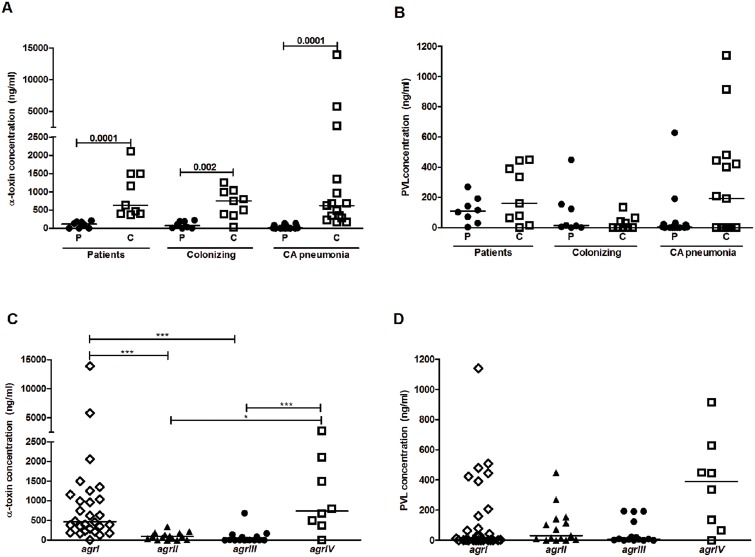
Levels of alpha-toxin expression correlate with cytotoxic profile and agr types.Amounts of alpha-toxin (α-toxin) (A) and Panton Valentine Leukocidin (PVL) (B) were determined by ELISA in the S. aureus bacterial supernatants (1∶50 dilutions) having either a cytotoxic (C; open symbols) or a proliferative (P; filled symbols) response profile. Supernatants prepared from isolates collected from colonized individuals (n = 17), patients (n = 17), or a confirmatory cohort of CA pneumonia (n = 31) are shown. Association between amount of α-toxin (C) and PVL (D) in the S. aureus bacterial supernatants (1∶50 dilutions; n = 65) with their respective agr types (agr I and IV, open symbol; agr II and III, filled symbol). Statistical significant differences were determined by use of the two-sided Mann Whitney test or with ANOVA and Dunn's multiple comparison test for comparisons of multiple groups and p values are indicated in the figure.